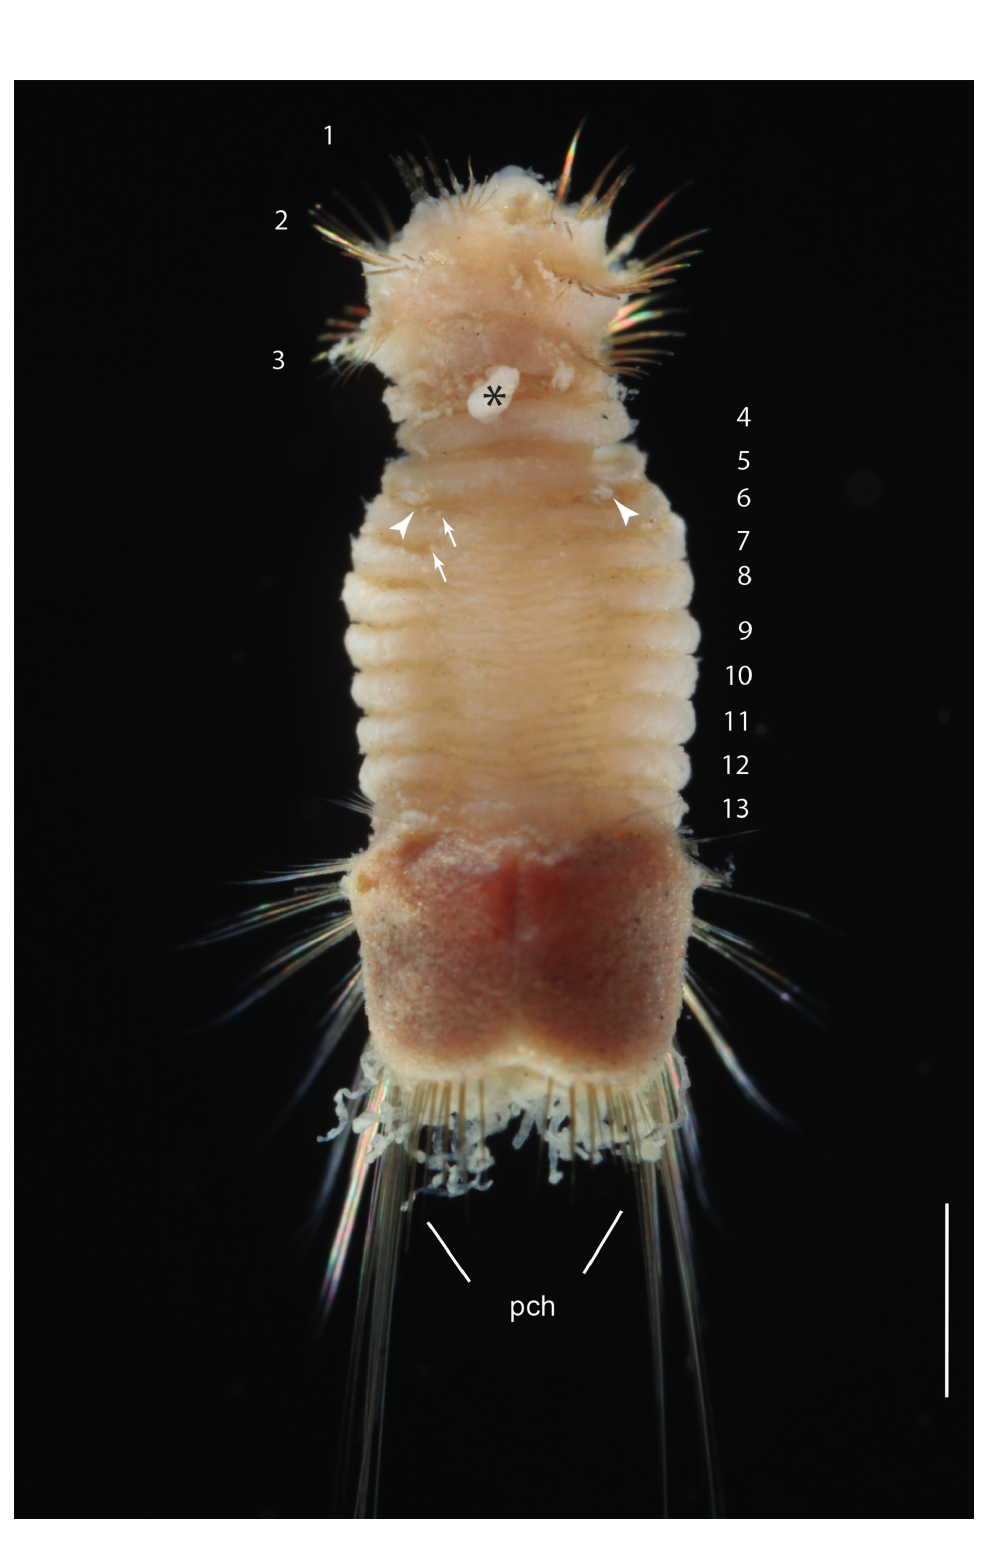
Fig. 1. Mauretanaspis longichaeta gen. et spec. nov., holotype (MNHN-IA-TYPE 2005), ventral view. Abbreviation: pch = posterior shield chaetae; * = body damaged with oesophagus protruding; numbers 1–13 = anterior and pre-shield segments; arrowheads = gonopodial lobes; arrows = body papillae. Scale bar: 1